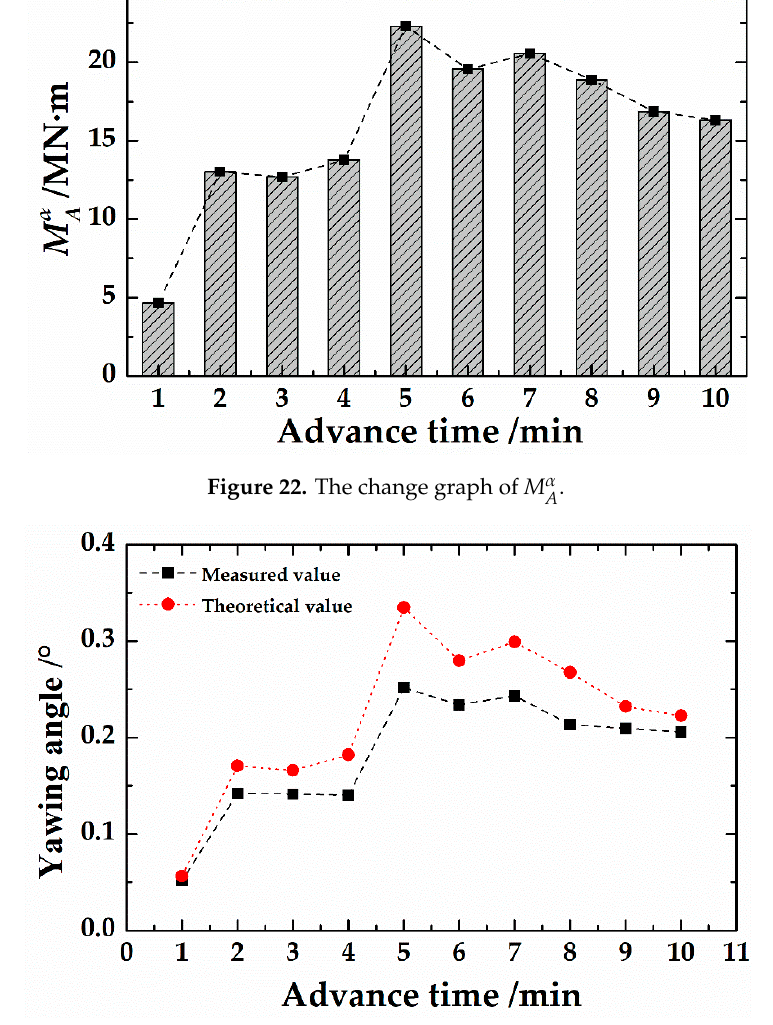
Figure 23. Contrast between the measured and the theoretical value of the shield yawing angle.